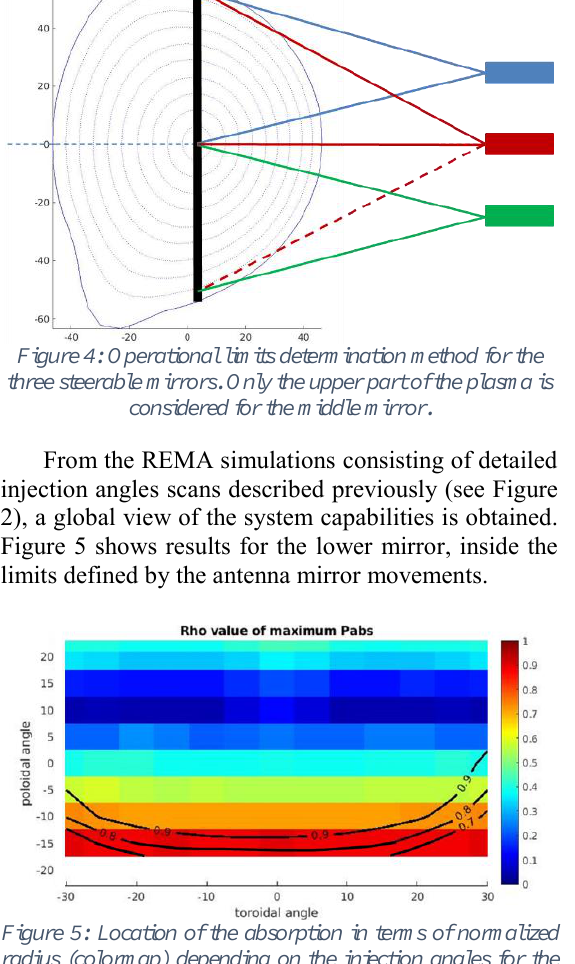
Figure 6: Operational domain for the three steerable